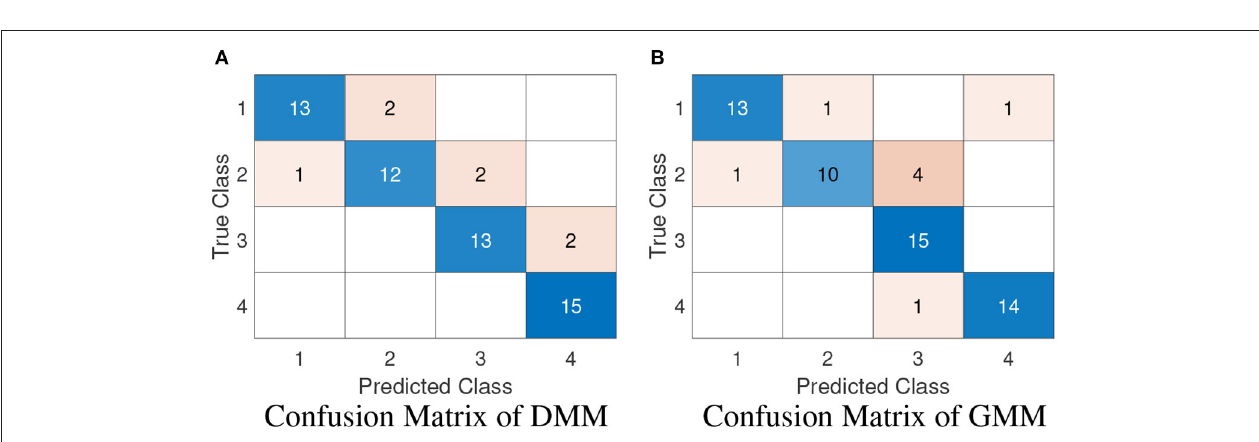
Frontiers in Applied Mathematics and Statistics |